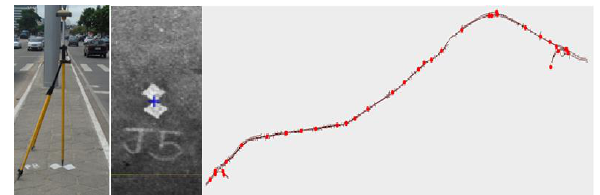
Figure 8. Control points along main road, in